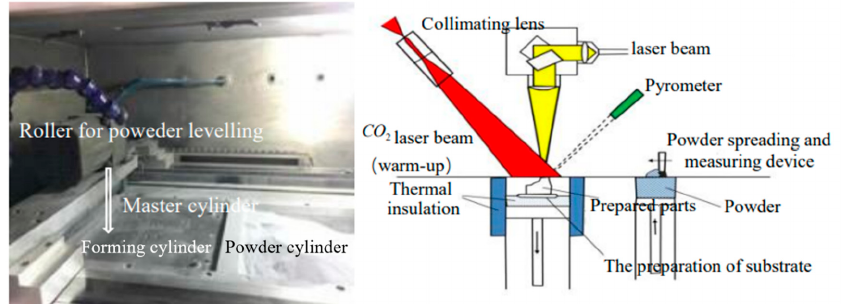
Figure 1. Space M200 manufacturing system.